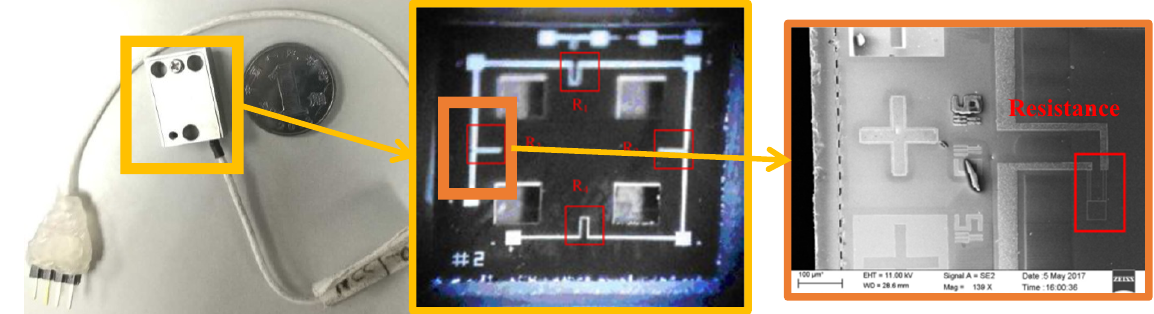
Figure 4. Overall photo, confocal microscopy photo and SEM photo of HGMA.